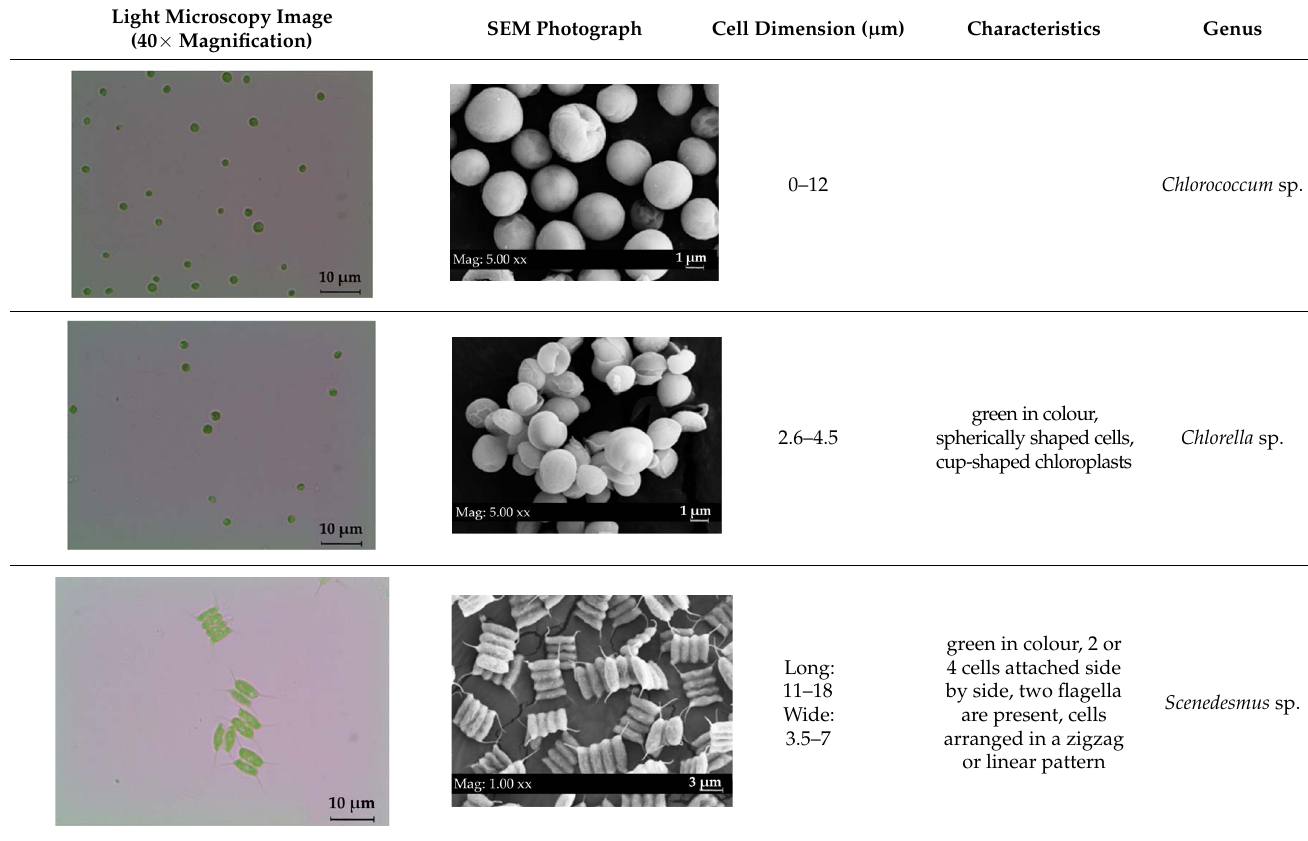
Table 2. Images and morphology of three green microalgae. Light Microscopy Image (40× Magnification)